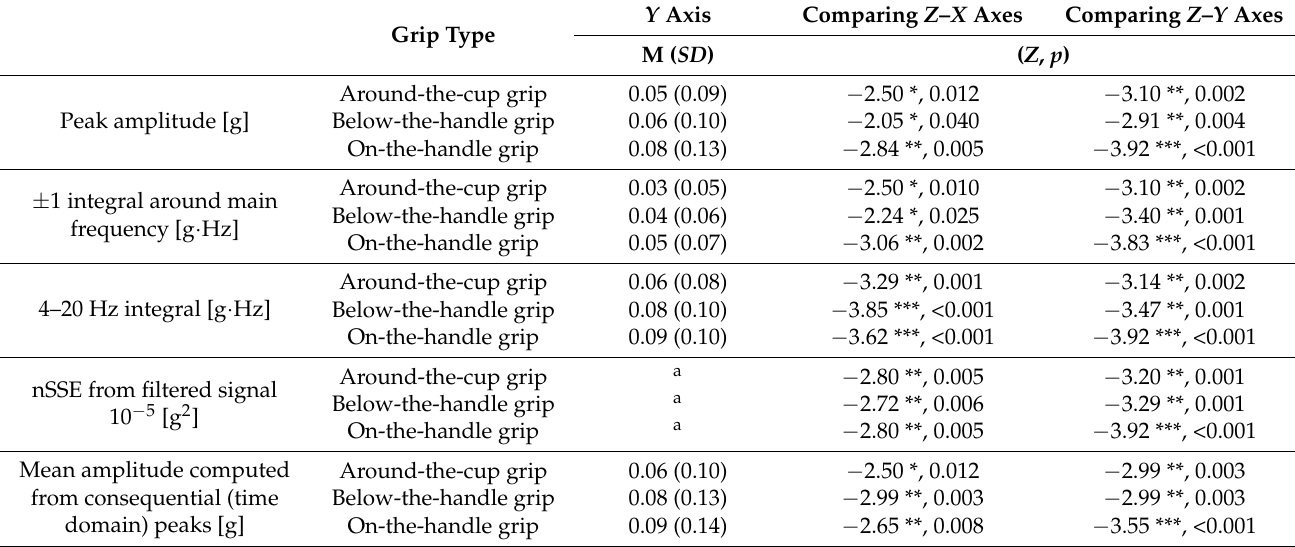
Table 2. Results of the Z – X and Z – Y Axes Comparisons. Y Axis Comparing Z – X